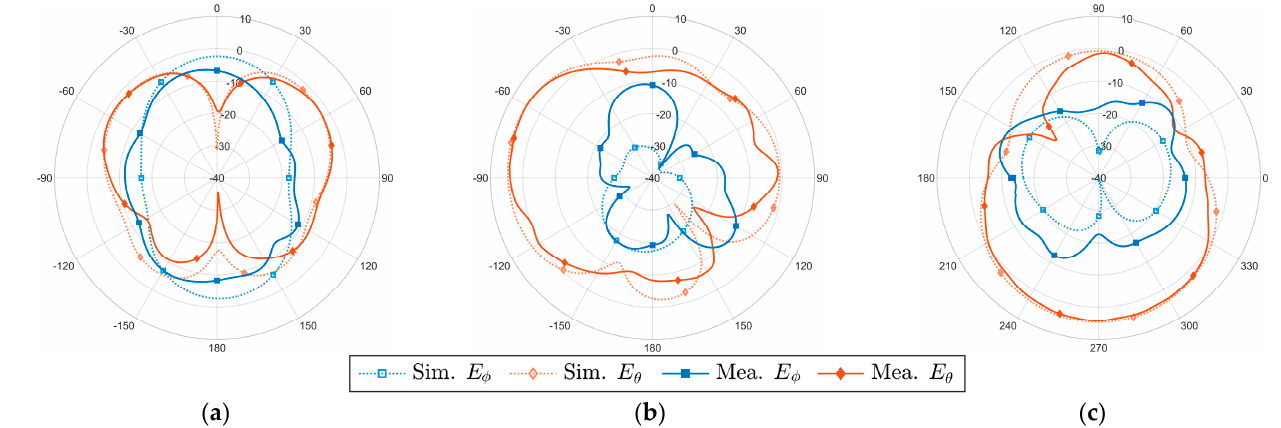
Figure 13. Radiation patterns of the decoupled array when port 1 is activated: ( a ) xoz plane; ( b ) yoz plane; and ( c ) xoy plane.